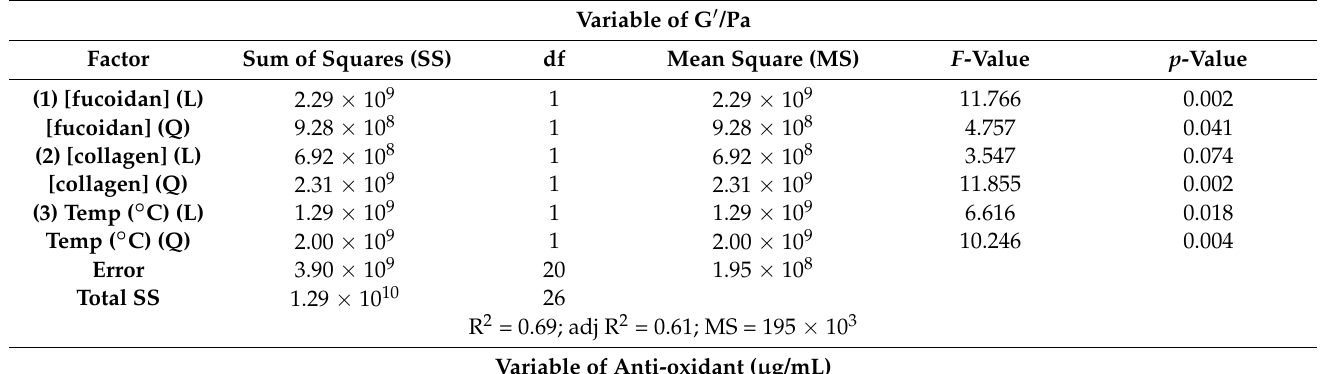
Table 5. Analysis of variance (ANOVA) for the fitted quadratic polynomial model for optimization of cryogel